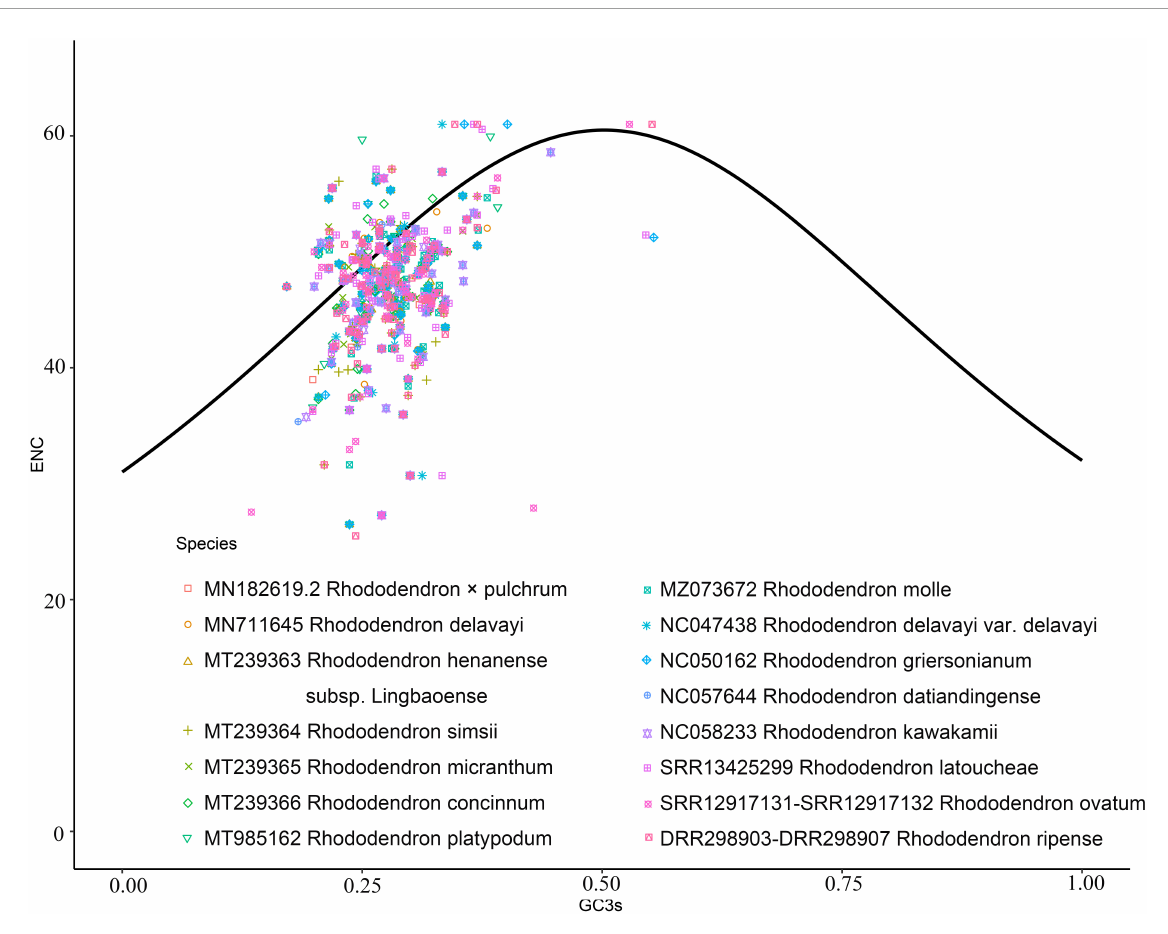
FIGURE8 ENC Plot analysis of genes in 12 Rhododendron species chloroplast genomes. (Y-axis: Effective number of codons value of gene; X-axis: GC3 content of gene; Standard curve line is calculated as follows: ENC = 2 + GC3 + 29/(GC3 2 + (1-GC3) 2